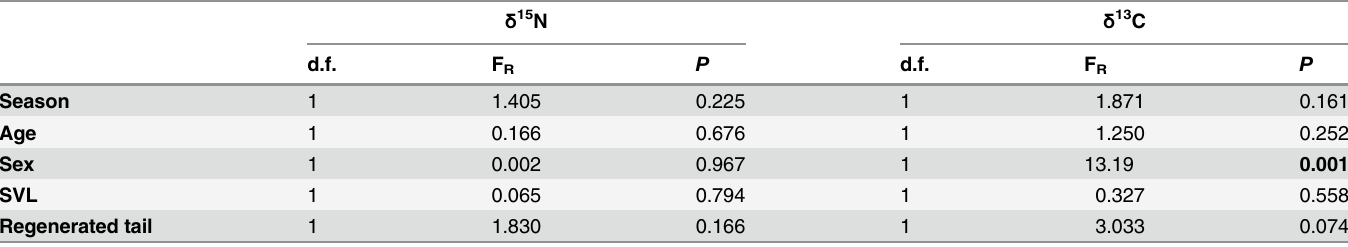
Season: proportion of individuals sampled in summer; Age: proportion of sampled adults; Sex: proportion of adult females when juveniles were not considered; SVL, Snout-vent length; Regenerated tail: proportion of sampled individuals with clear sign of regenerated tail. Signi fi cant result ( P < 0.05) in